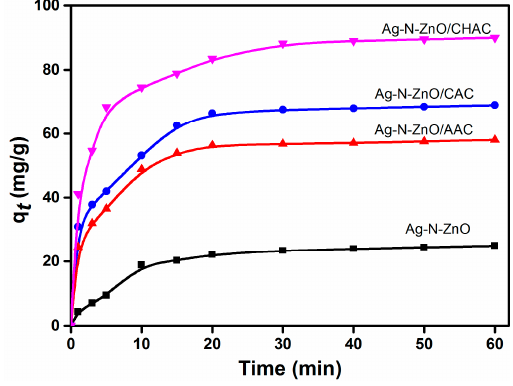
Figure 6. Adsorption kinetics of MO on the four composite photocatalysts.